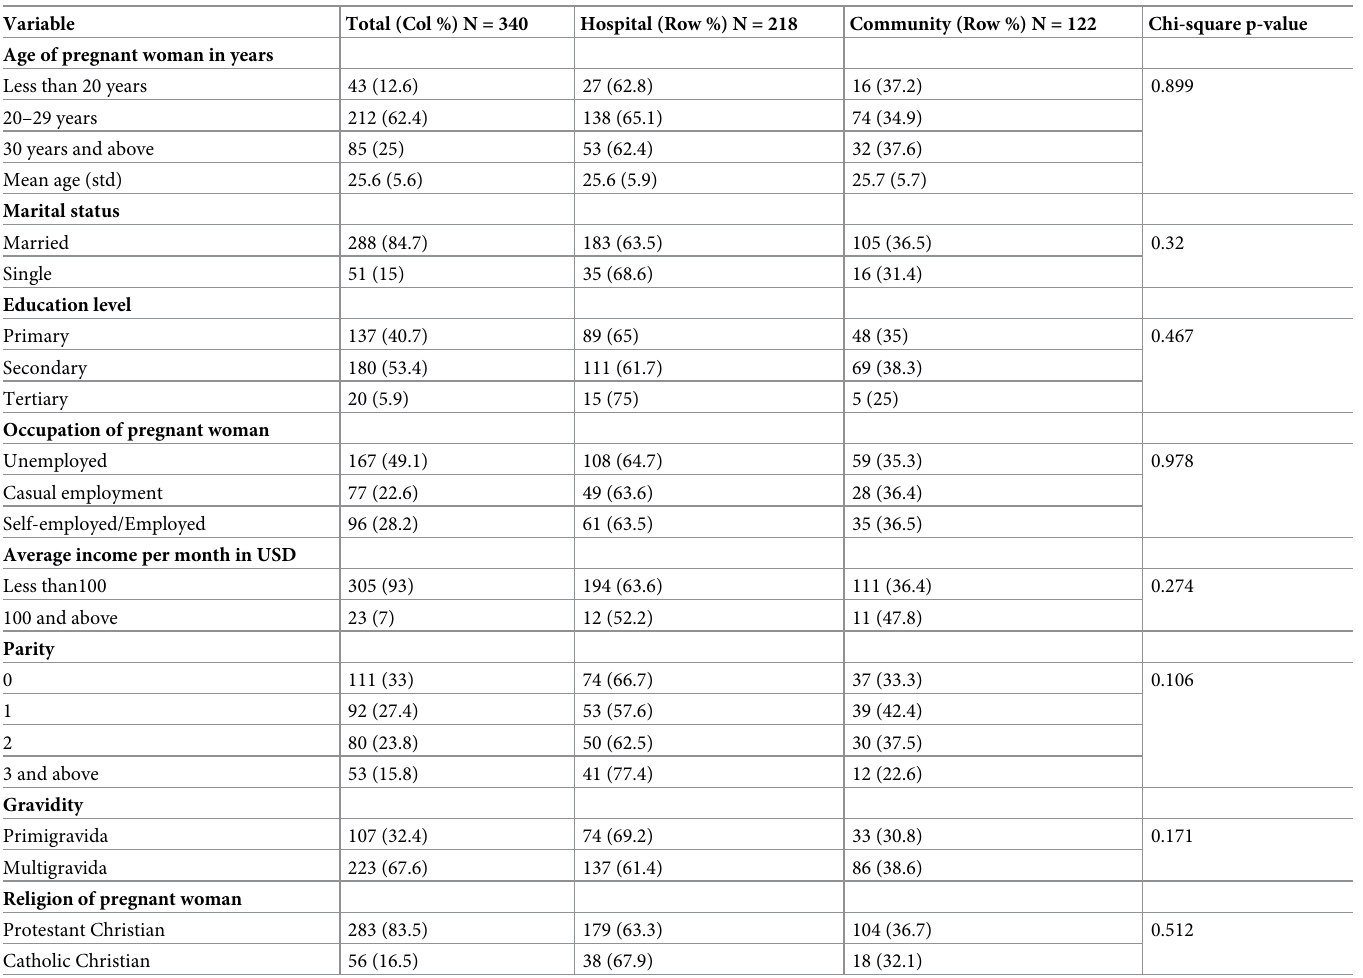
Table 2. Socio-demographic profile of the study respondents at baseline by